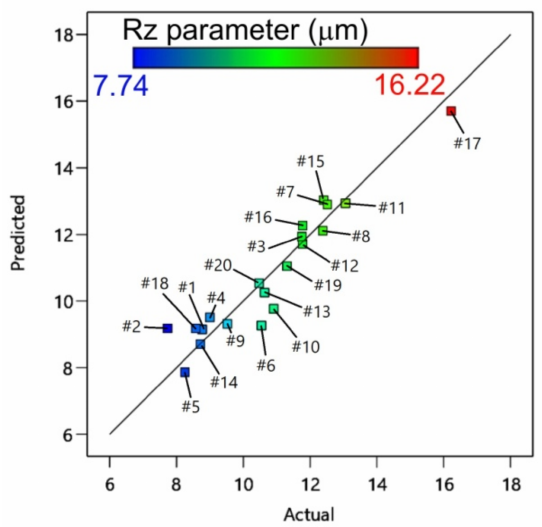
Figure 13. Predicted versus actual response for the surface parameter Rz.